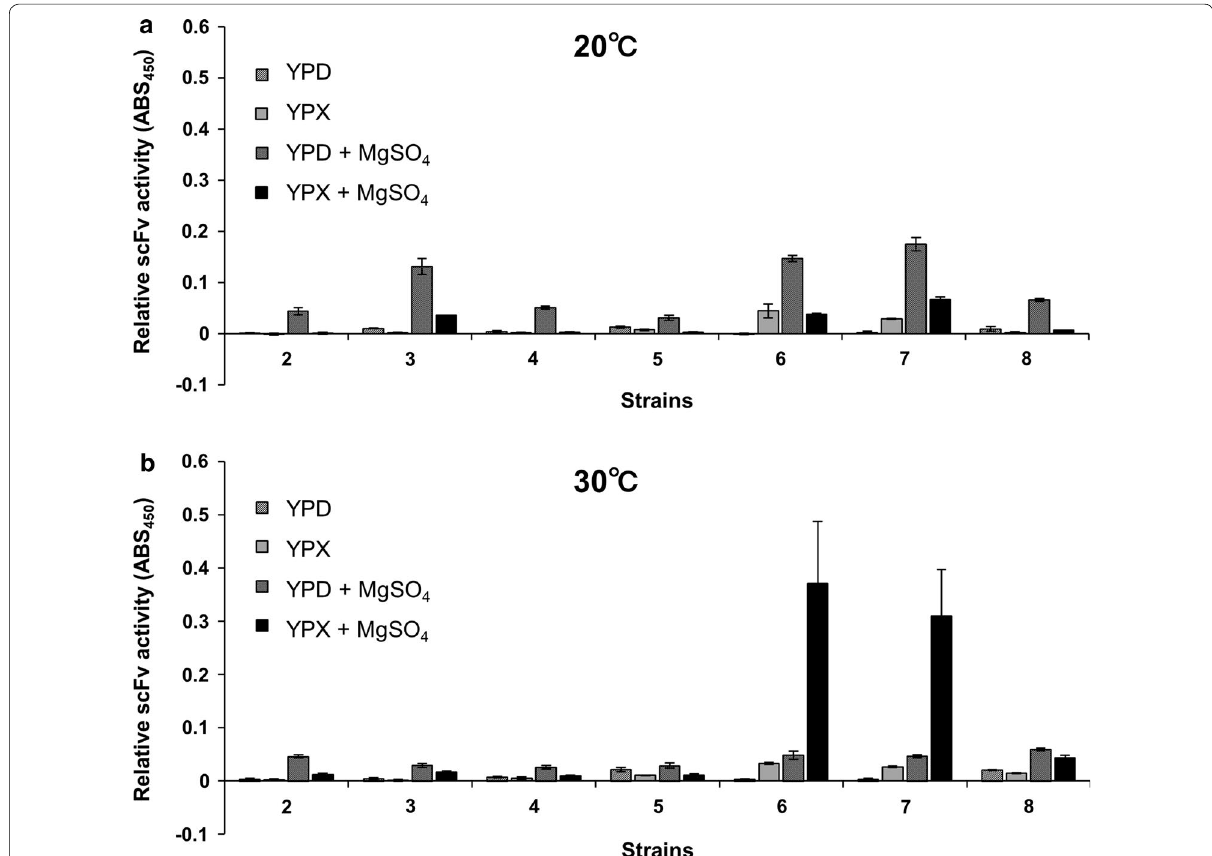
Fig. 4 Immunoreactivity of secreted scFv analyzed by ELISA. Strains were cultured in YPD or YPX in the absence or presence of MgSO 4 at 20 °C ( a ) or 30 °C ( b ). Spent culture medium was harvested at 72 h and subjected to ELISA using lysozyme as an antigen for scFv. Values are presented as mean SEM from three independent ±